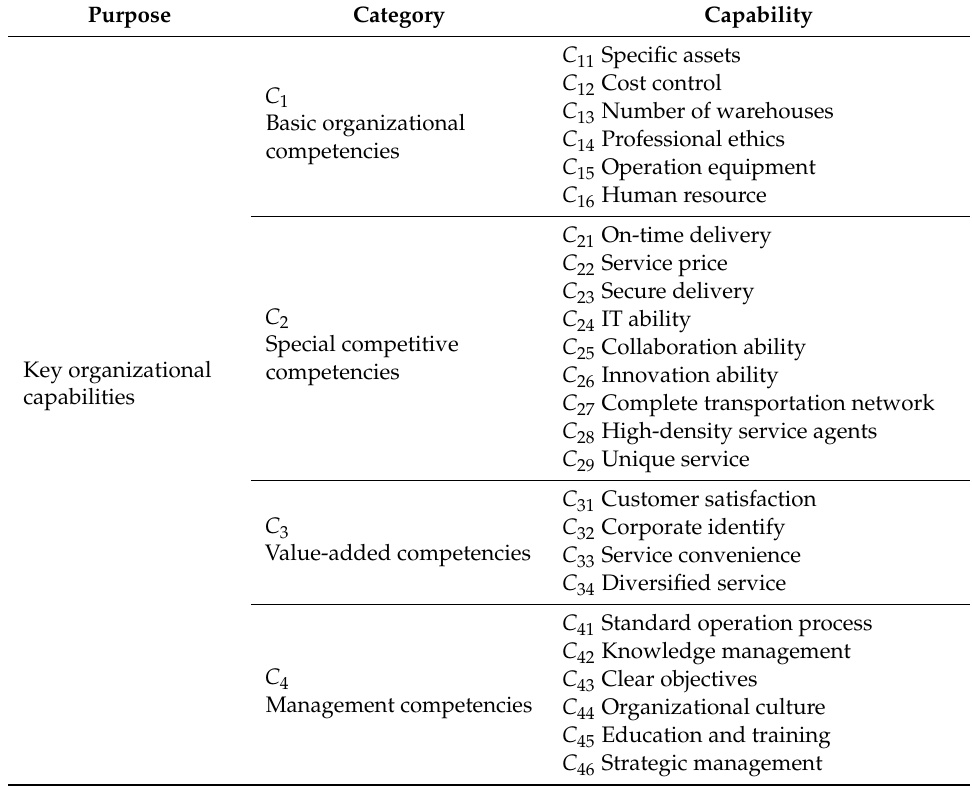
Table 2. The hierarchical structure of organizational